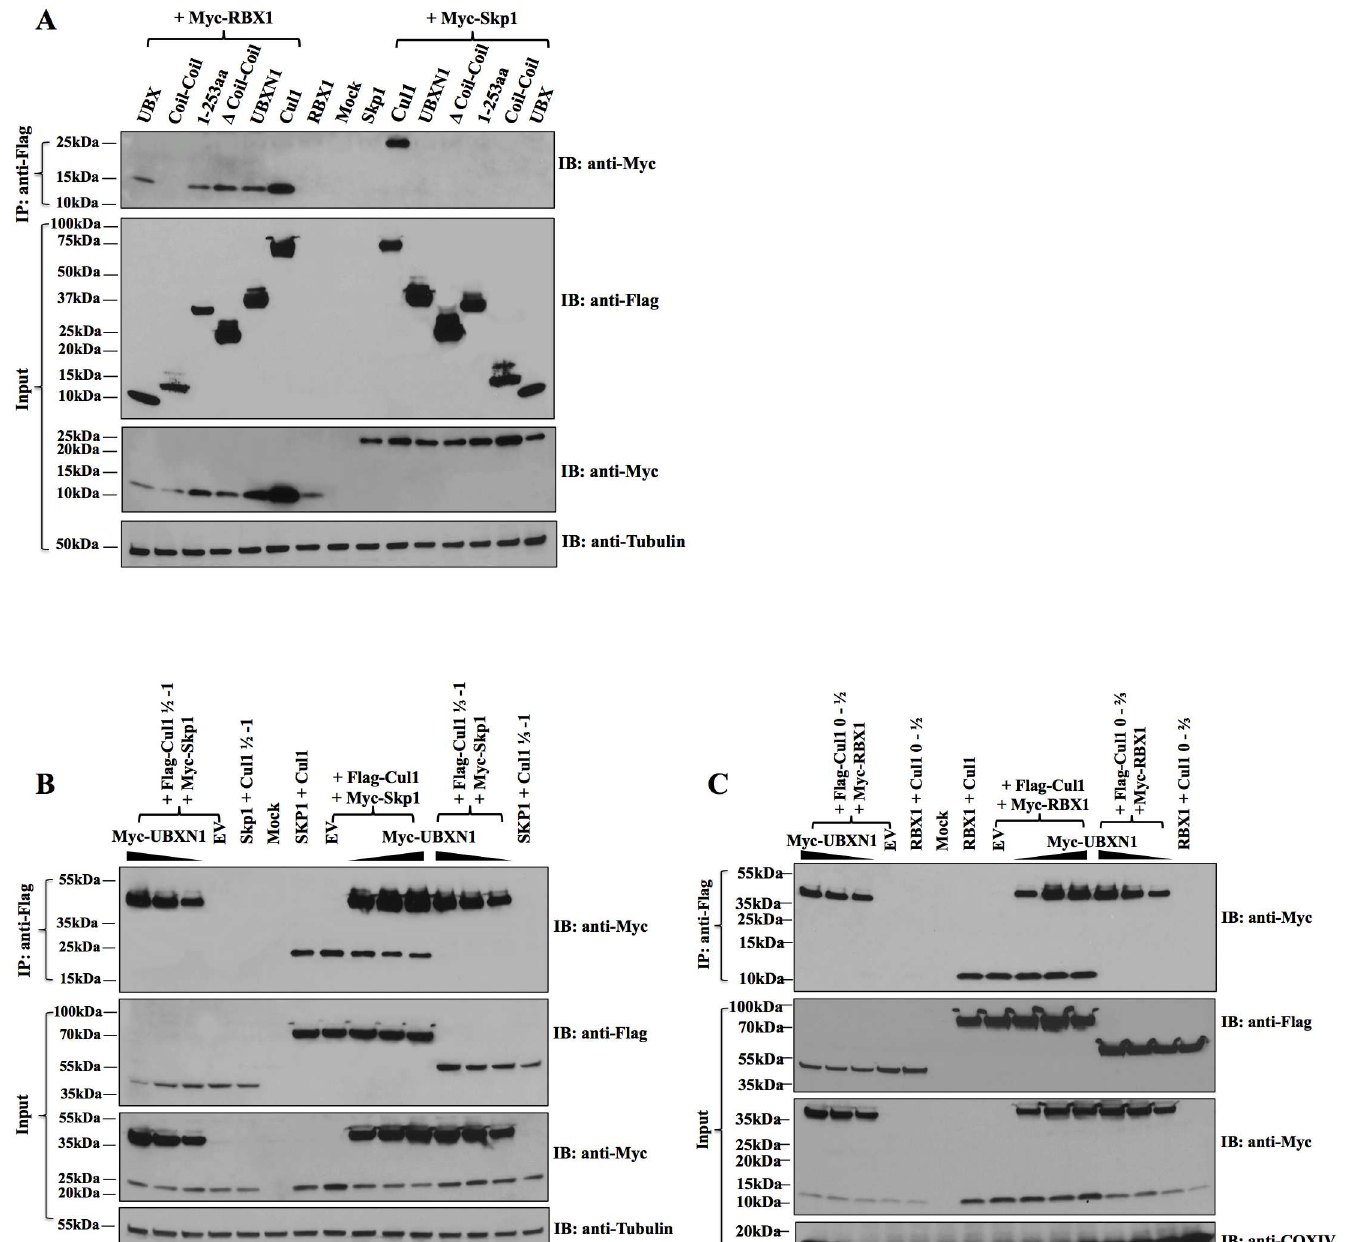
Fig 4. Co-immunoprecipitation of UBXN1, Rbx1, Skp1, and Cul1. (A) 293T cells were transiently transfected with the indicatedFLAG-UBXN1 constructs or FLAG-Cul1 in the presenceof either Myc-Rbx1 or Myc-Skp1 as indicated,with co-IP at top and input, including β -tubulin, at bottom; (B) Similar to (A) , except decreasingamounts of Myc-UBXN1 were transfected along with Myc-Skp1 and either empty vector (EV), ½ -1 FLAG-Cul1, FLAG-Cul1, or 1/3-1 FLAG-Cul1, as indicated,with co-IP at top and input, including β -tubulin, at bottom; (C) Similar to (B) , except that Myc-Rbx1 was transfected along with EV, either 0-1/2 FLAG-Cul1, FLAG-Cul1, or 0-2/3 FLAG-Cul1, as indicated, with co-IP at top and input, including Cox IV, at bottom. Note that co-expression of Cul1 increasedRbx1 levels.